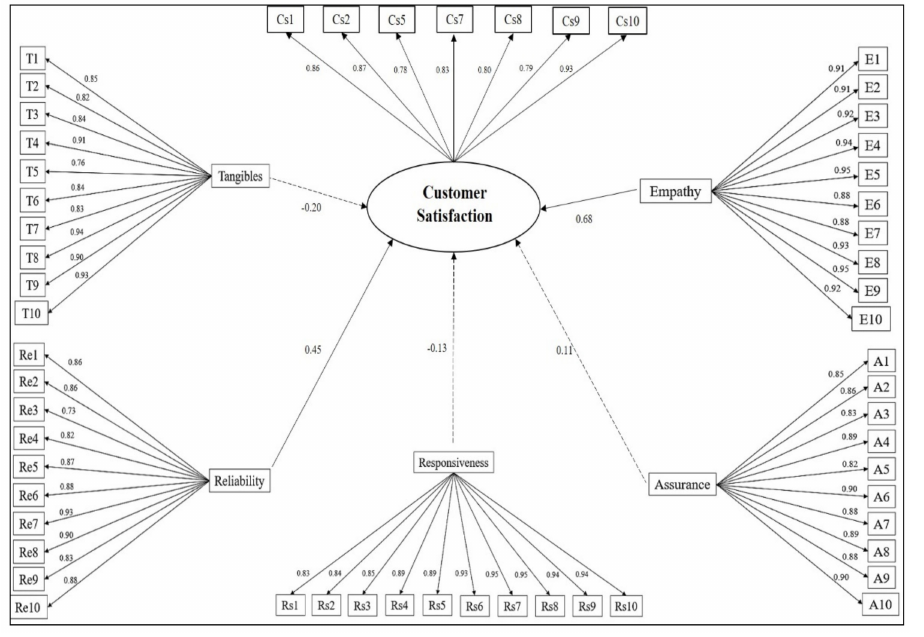
Figure 2. SEM Initial